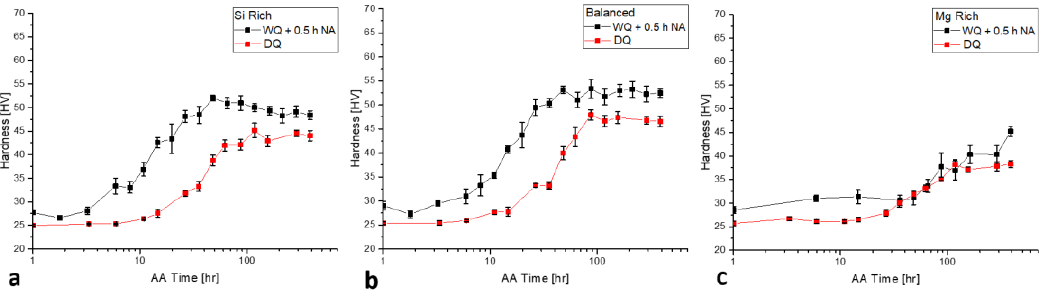
Figure 13. Conductivity evolutions during aging in the low strength alloys after AC from ST, labelled accordingly. The primary axes correspond to AA (with 0.5 or 4 h prior NA), and the secondary axes correspond to NA itself. Error bars represent 95% confidence, and the discrepancy is for the same reason as Figure 4.